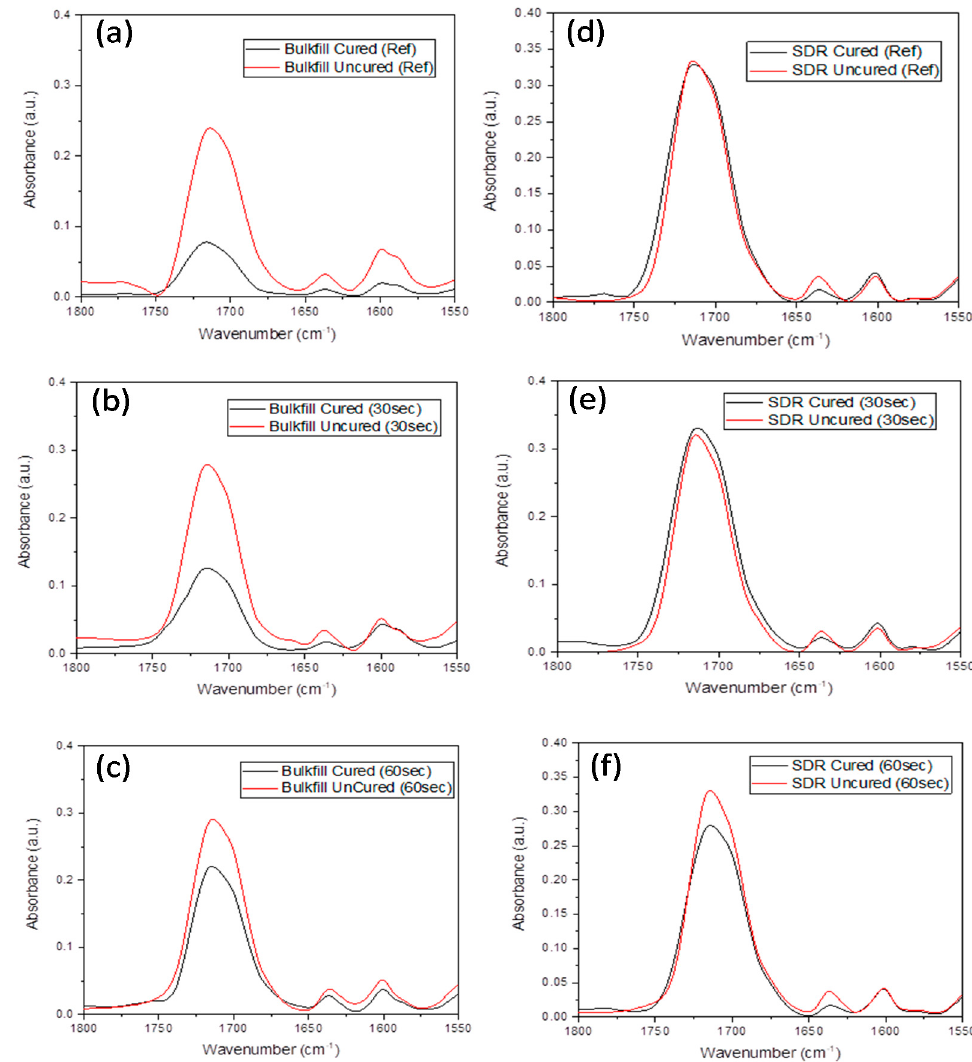
Figure 2. Comparative FTIR spectra of uncured and cured Bulk-fill composite ( a ) without ultrasonic application, ( b ) 30 s ultrasonic application, and ( c ) 60 s ultrasonic application. The comparative FTIR spectra of cured and cured SDR composite ( d ) without ultrasonic application, ( e ) 30 s ultrasonic application, and ( f ) 60 s ultrasonic application. The change in intensity was observed at 1715 cm − 1 (C=O), 1635 cm − 1 (aliphatic), and 1602 cm − 1 (aromatic).